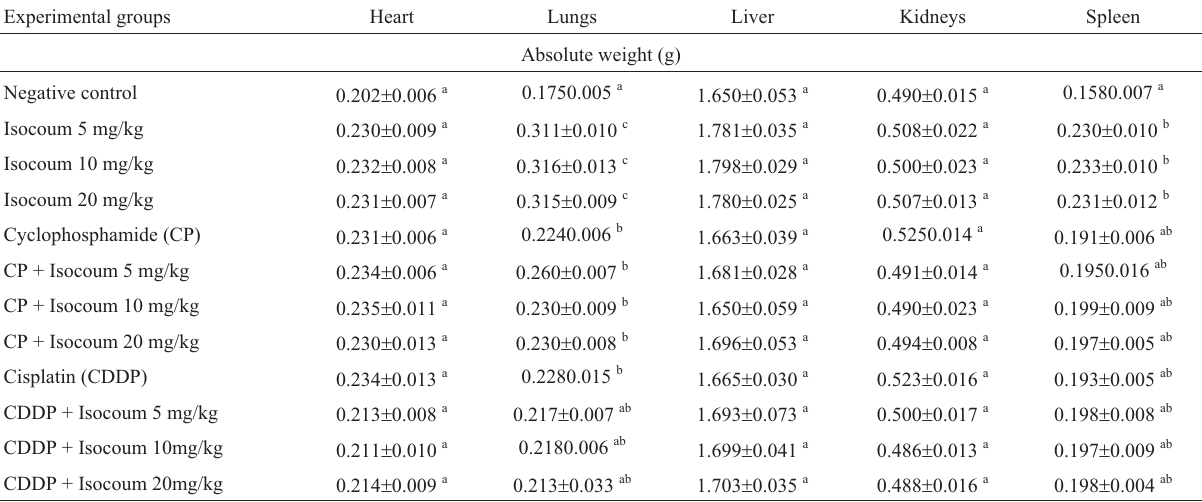
Table 2 - Means (cid:5) SE of the absolute weights of the animals’ organs after the experimentation period. Experimental groups